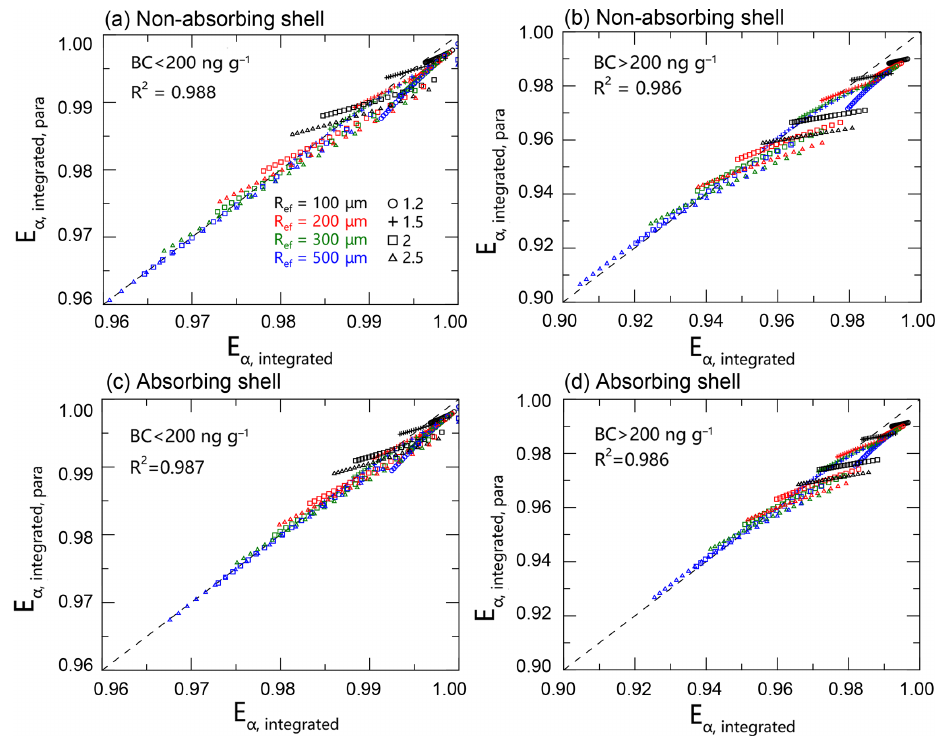
Figure 8. Comparisons of model-calculated E α, integrated and parameterized E α, integrated , para values for (a) relatively clean snow (BC concentration < 200ngg − 1 ) and (b) relatively polluted snow (BC concentration > 200ngg − 1 ) for a nonabsorbing shell. Panels (c) and (d) are the same as (a) and (b) , respectively, but for an absorbing